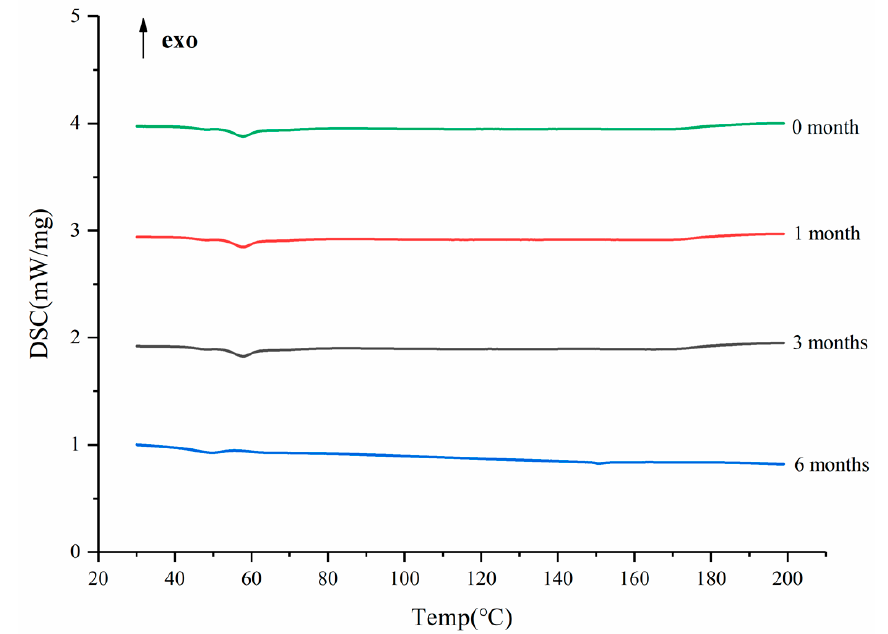
tion (n = 5, mean ± RSD).